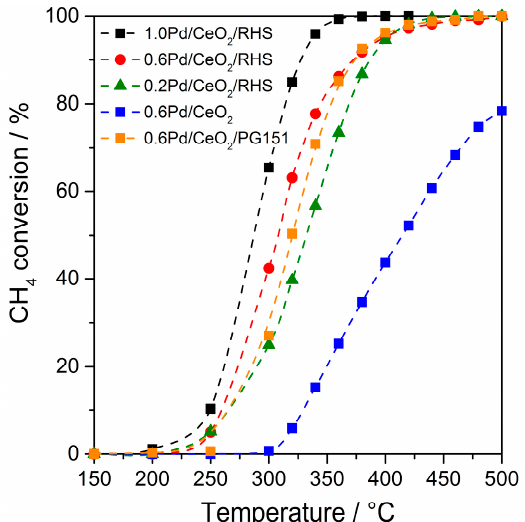
Figure 5. Methane catalytic activity of 0.6Pd/CeO 2 , 0.2Pd/CeO 2 /RHS, 0.6Pd/CeO 2 /RHS, 1.0Pd/CeO 2 /RHS, and 0.6Pd/CeO 2 /PG151 in dry feed gas (0.1 vol%-CH 4 , 9 vol%-O 2 , and 5.5 vol%-CO 2 balanced with N 2 ); 0.2 g catalyst, 75 mL/min flow rate; modified gas hourly space velocity, GHSV = 22.500 L kg cat − 1 h − 1 .